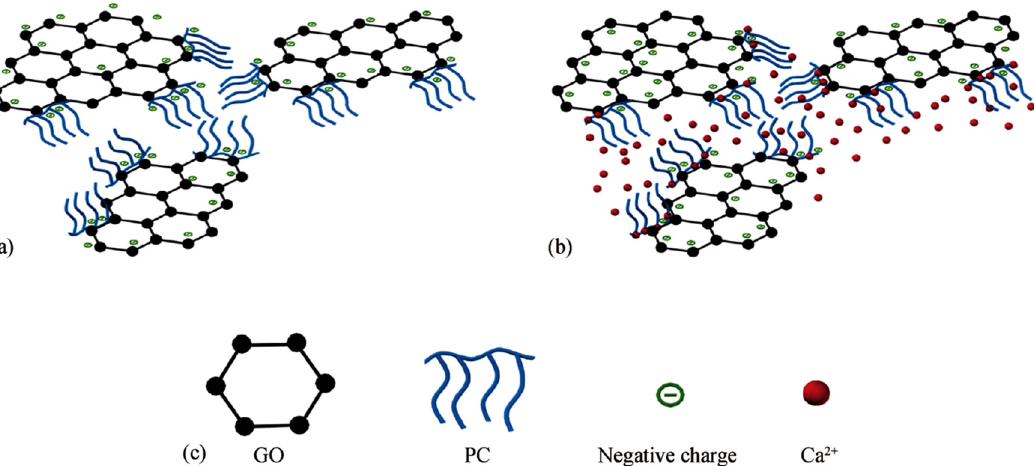
Figure 3: Dispersion mechanism of PC - GO [ 62 ] . ( a ) Dispersion mechanism in water, ( b ) dispersion mechanism in cement paste, ( c ) simulated structures of the GO, PC, negative charge and Ca 2 +